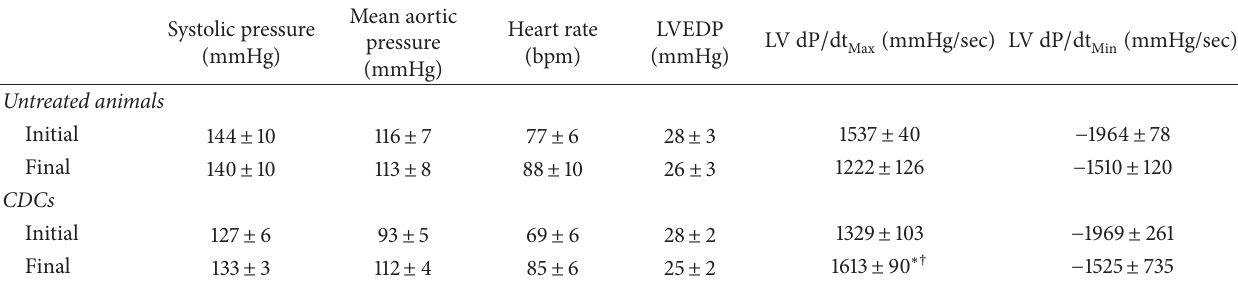
Figure 4: The effect of CDCs on cardiac function. In untreated controls, regional and global function assessed by echocardiography were severely reduced. After 4 weeks, CDCs significantly improved LAD and remote wall thickening, producing an improvement in LV ejection fraction. Table 2: The effects of CDCs on